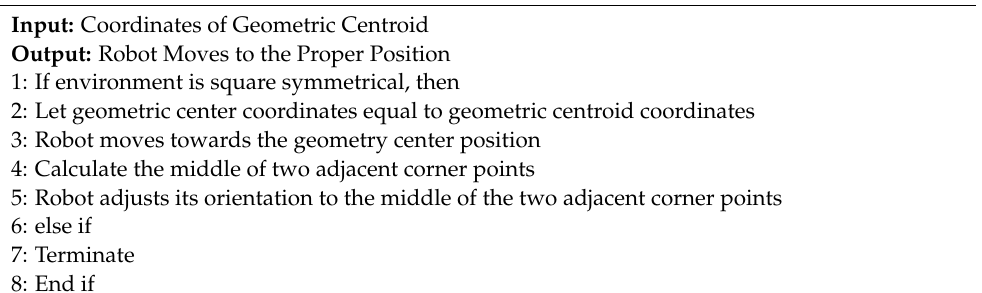
Algorithm 2. Robot Moves to Geometry Center Position